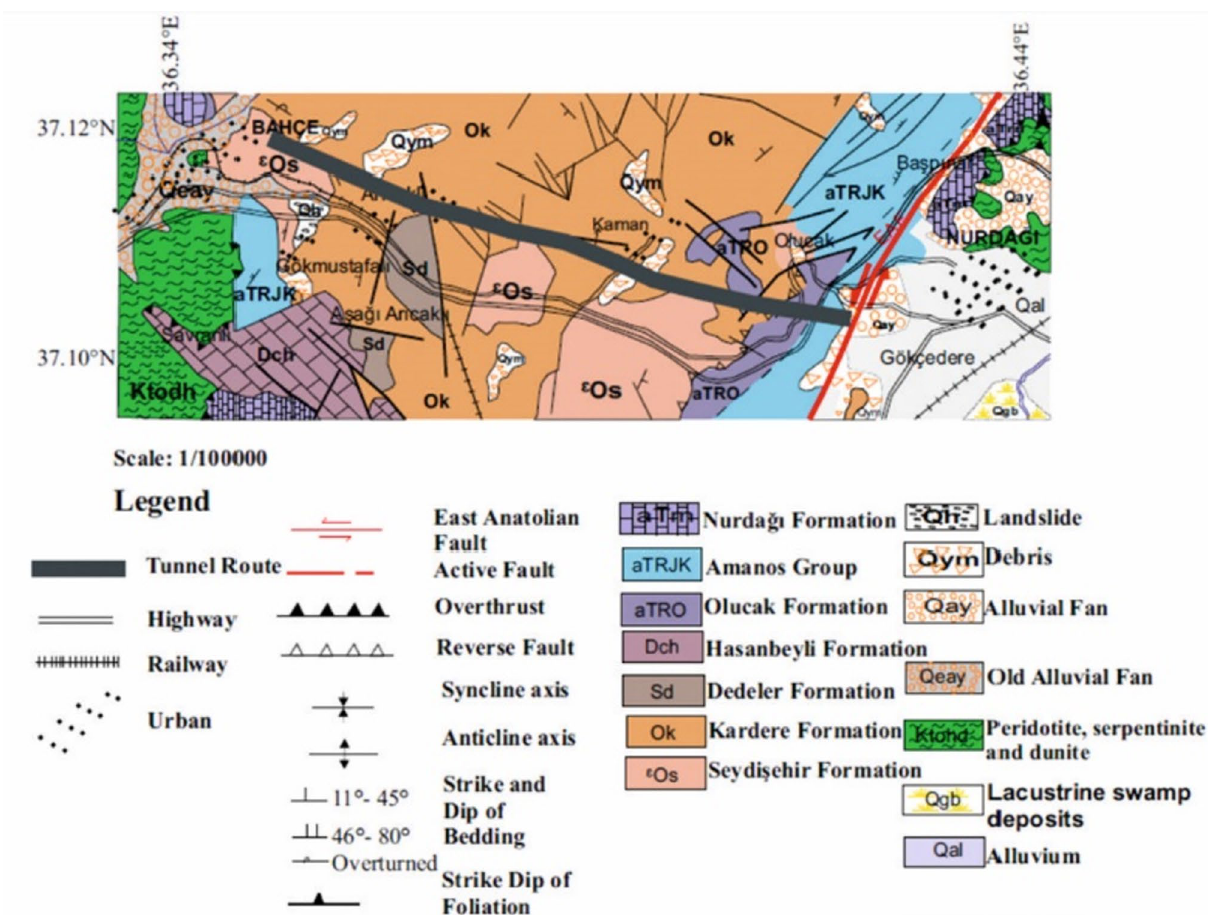
Fig. 3 Geological map of the tunnel route and its close vicinity